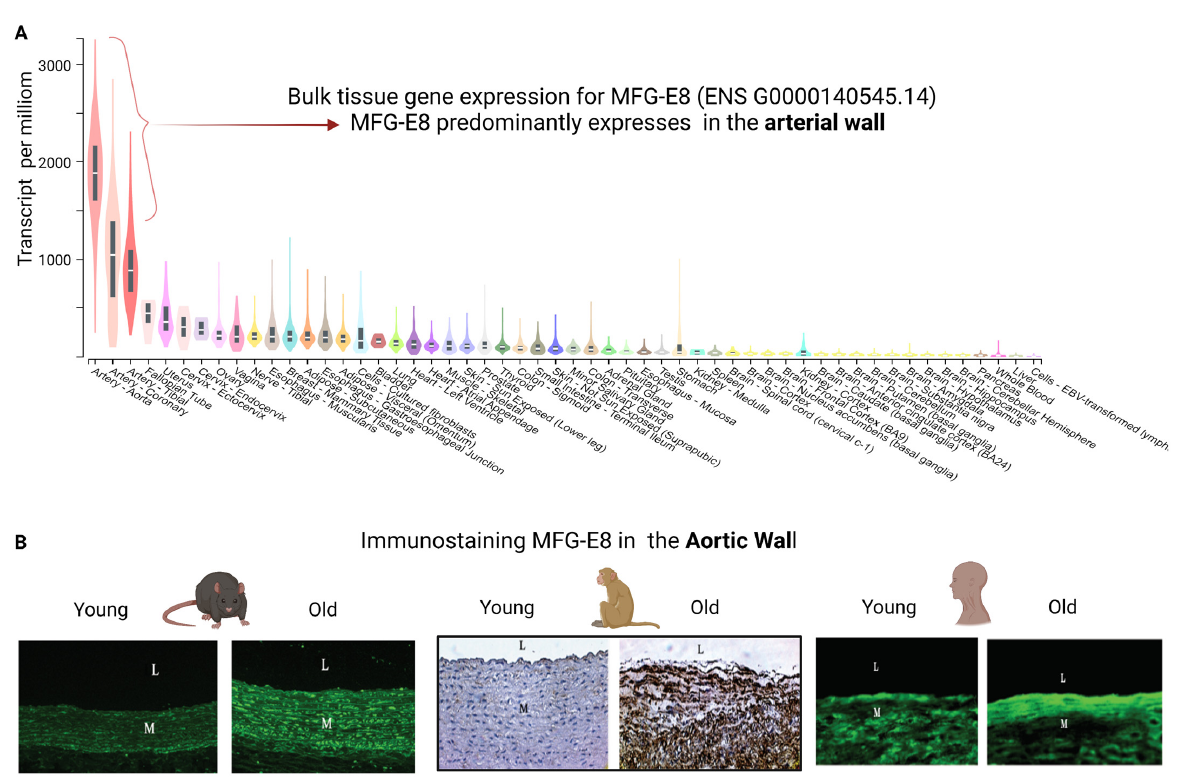
Figure 2. MFG-E8 expression in the aortic wall. ( A ) Bulk human tissue expression for MFG-E8 from the genotype-tissue expression (GTEx) project (version 8) (http://gtexportal.org/omr/ (accessed on 23 October 2022)), showing that MGF-E8 is highly expressed in arteries, especially in the aorta. ( B ) Immunostaining MFG-E8 in the aortic walls in aging rats, nonhuman primates and human samples, modified from Wang M et al. [10]. MFG-E8, milk fat globule EGF VIII. L, lumen; M. media. Created with BioRender.com.